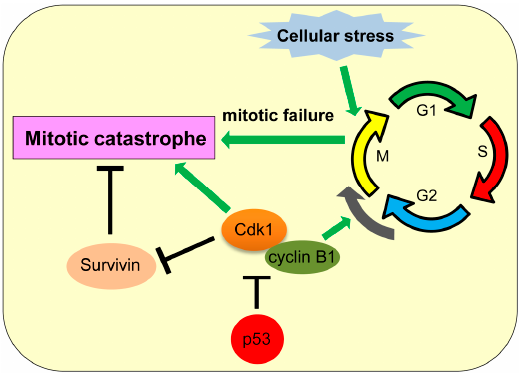
Figure 5. Mitotic catastrophe and its association with p53. p53 inhibits transcription of cyclin-dependent kinase 1 (cdk1) and cyclin B1 to inhibit mitotic catastrophe.